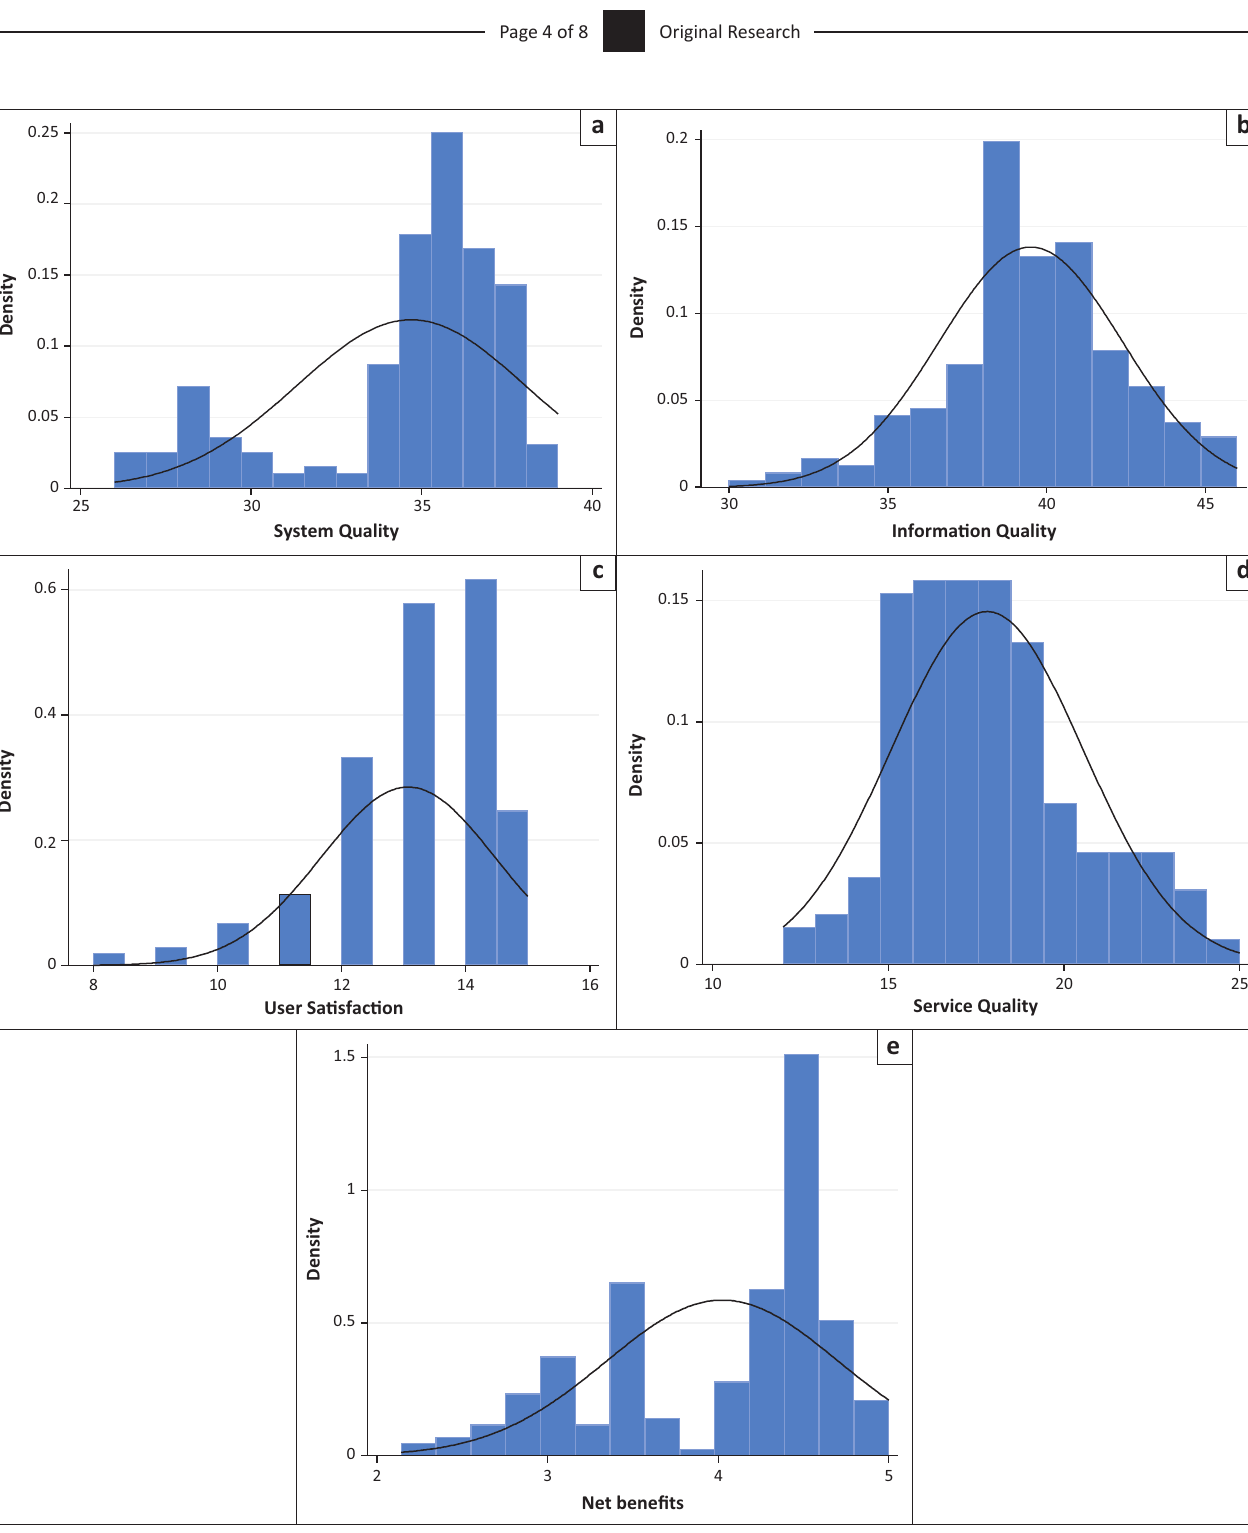
FIGURE 2: Histograms and curves for key study variables: (a) system quality; (b) information quality; (c) user satisfaction; (d) service quality; (e) net